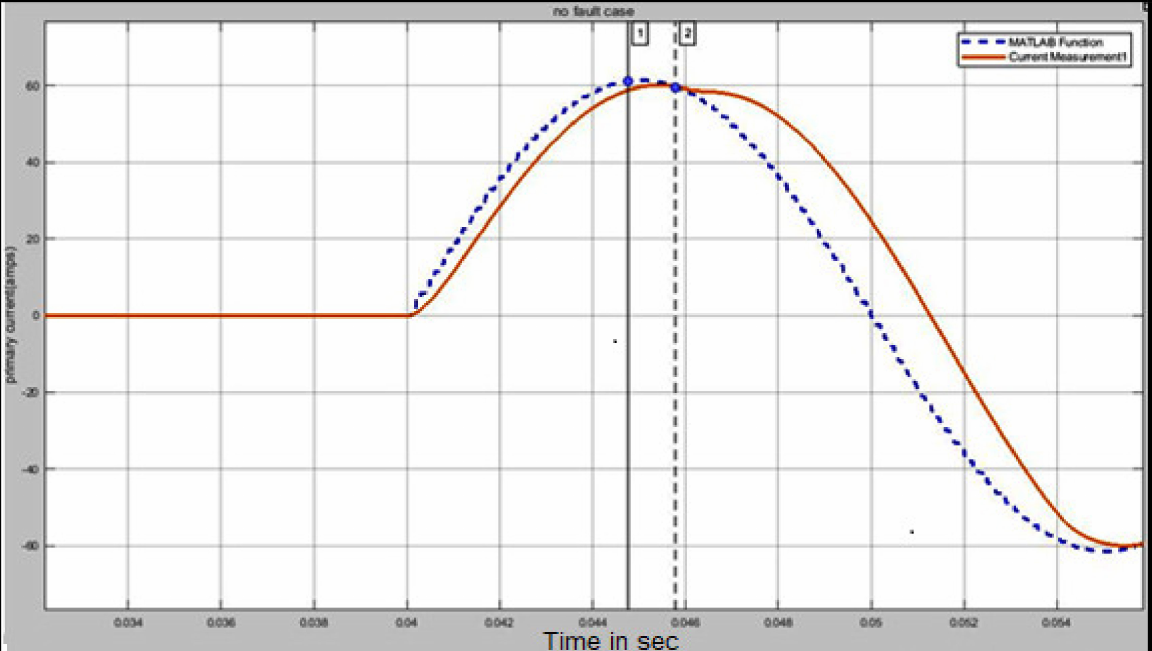
Figure 16. Close up view of EKF estimation during inrush case (red line depicts actual current where the blue line is the estimated current